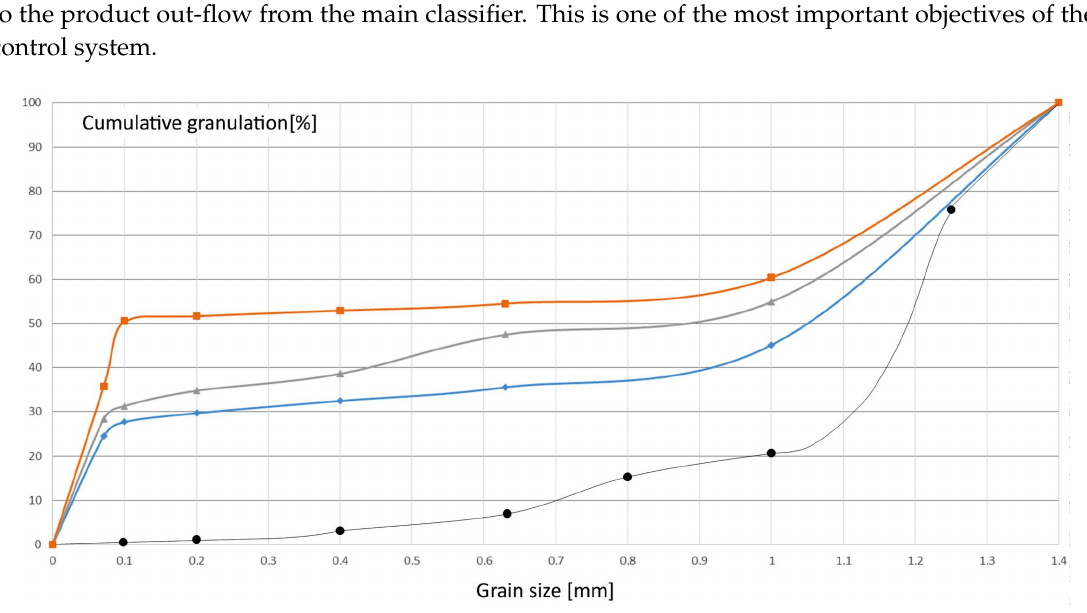
Figure 5. Cumulated mass curves of copper ore (black line—feed, blue line—product obtained for the feed volumetric flow Ff = 0.307 Mg/h, grey line—product with Ff = 0.154 Mg/h and orange line—product with Ff = 0.077